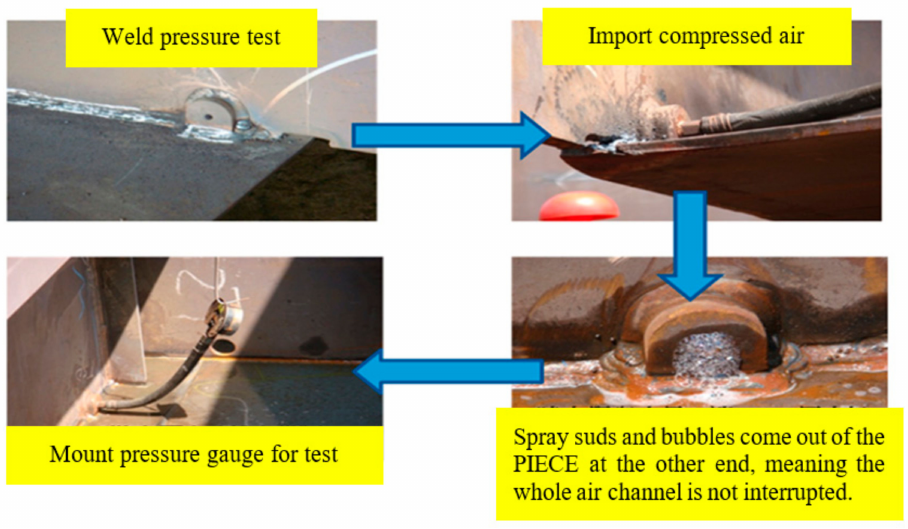
Figure 4. BLOCK pressure test